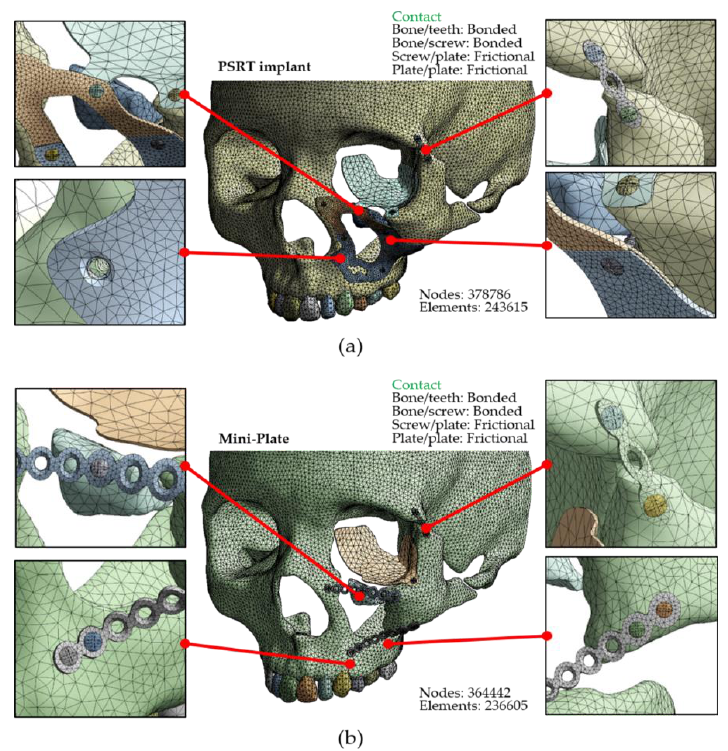
Figure 5. Finite analysis (FE) mesh models with element/node numbers and interfacial setting conditions for facial skeletal ZMC comminuted fracture fixation with ( a ) the PSRT implant by six screws surrounding the implant and ( b ) two traditional mini-plates at upper and lower parts between the remaining part of the infraorbital rim and zygomatic process bone were